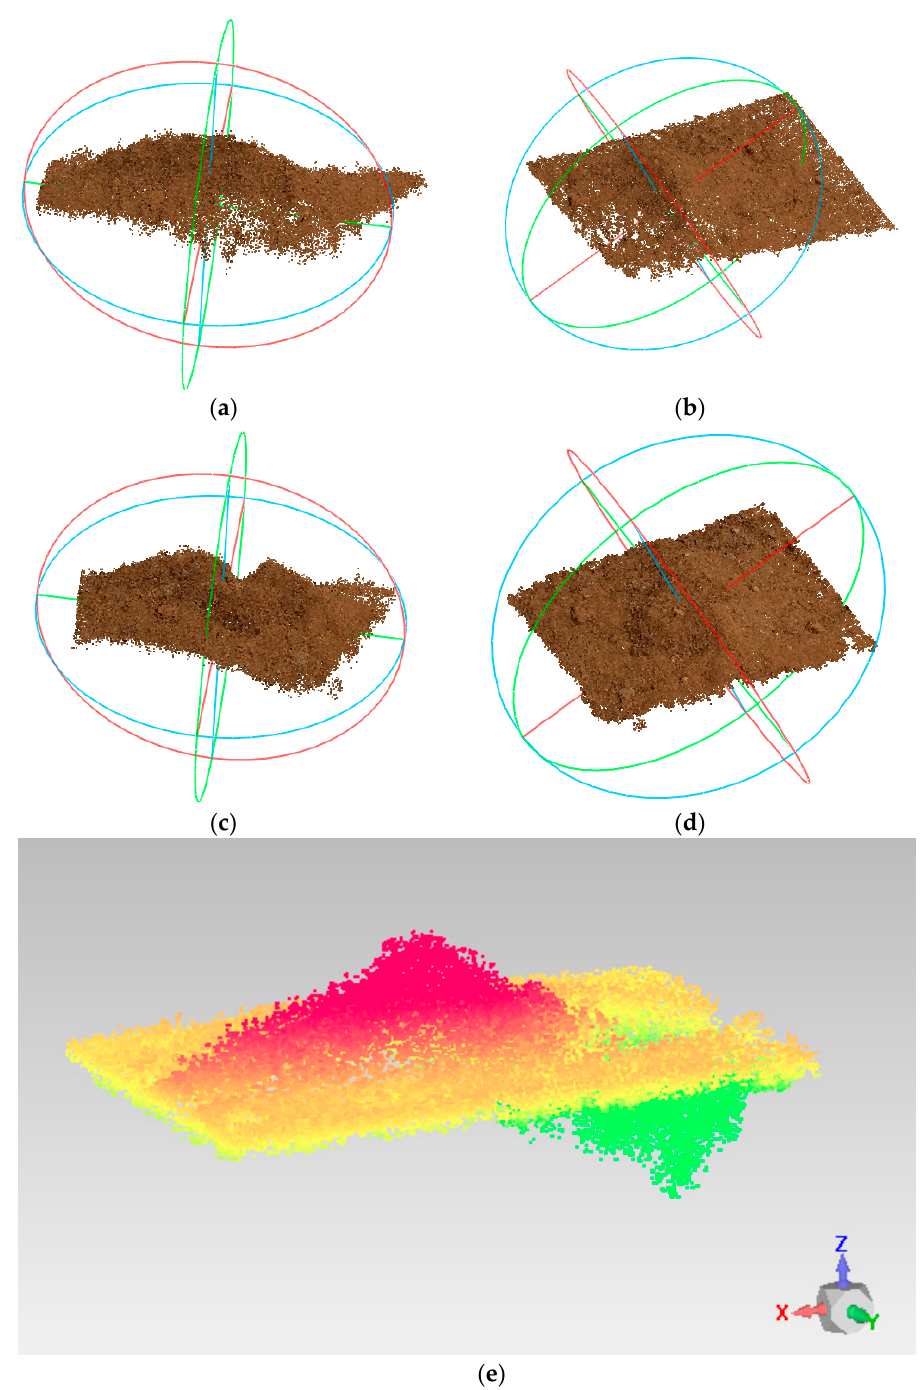
Figure 11. Reconstruction and comparison results before and after soil collection. ( a ) Before collection (horizontal view); ( b ) Before collection (vertical view); ( c ) After collection (horizontal view); ( d ) After collection (vertical view); ( e ) Results of point cloud comparison for area D in the gravity direction.